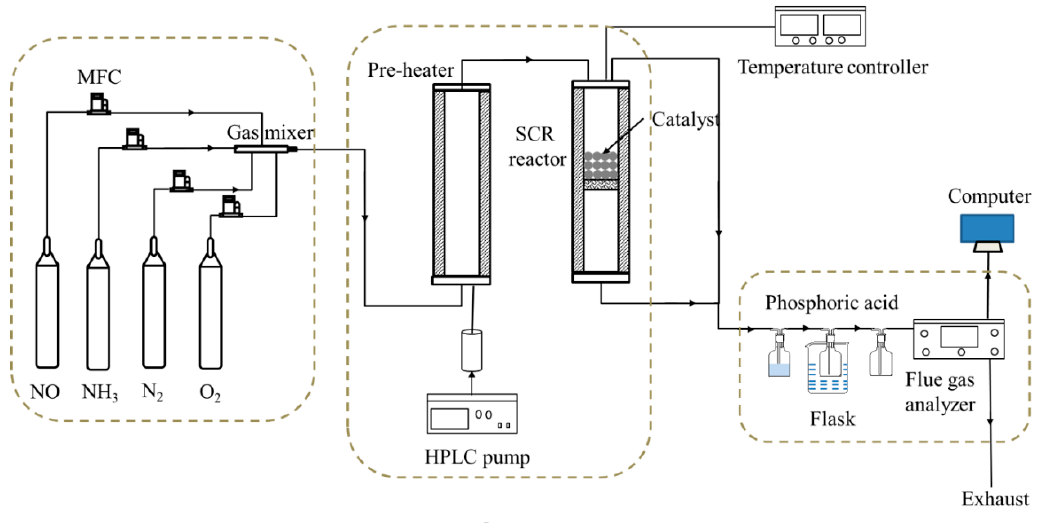
Figure 6. The schematic diagram of the experimental setup for De-NO x